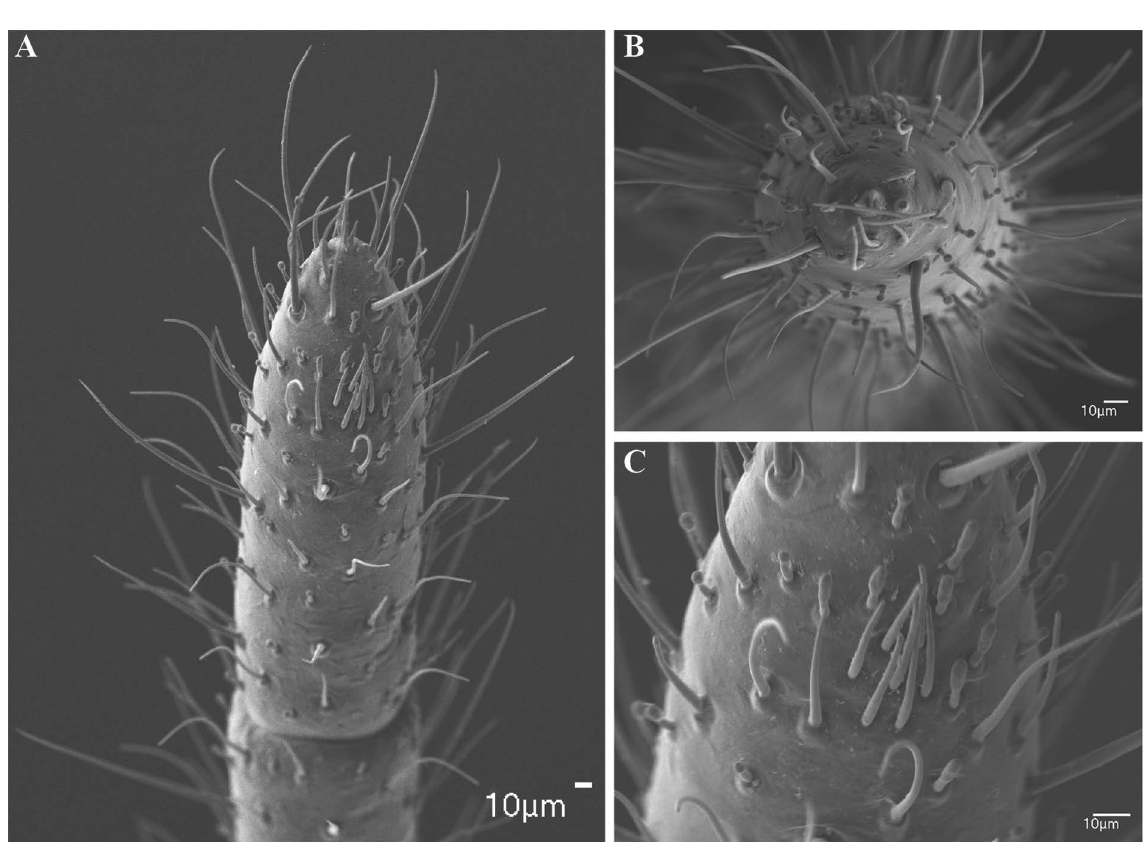
Fig. 51. Charinus carinae sp. nov. (MNRJ 9199), antenniform leg I, ♂. A . Apex, ventral view. B . Apex, frontal view. C . Rod sensilla with